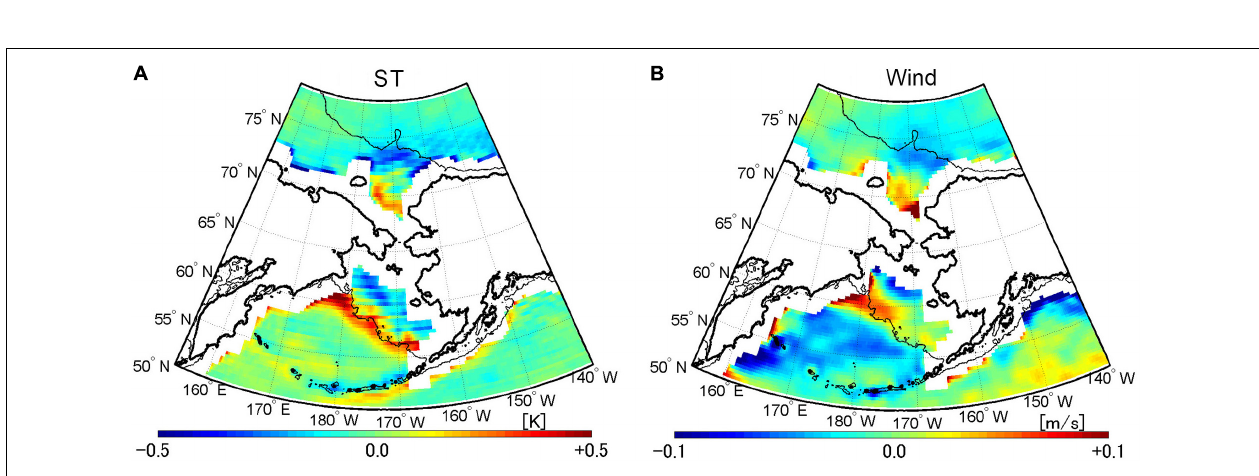
FIGURE 10 | Annual-mean climatology of spatially high-pass-filtered (A) ST and (B) 10-m-high wind speed. The high-pass-filtered anomaly is derived as the deviation from the 5 × 5 grid mean. Black thin lines are depth contours of 200 m.